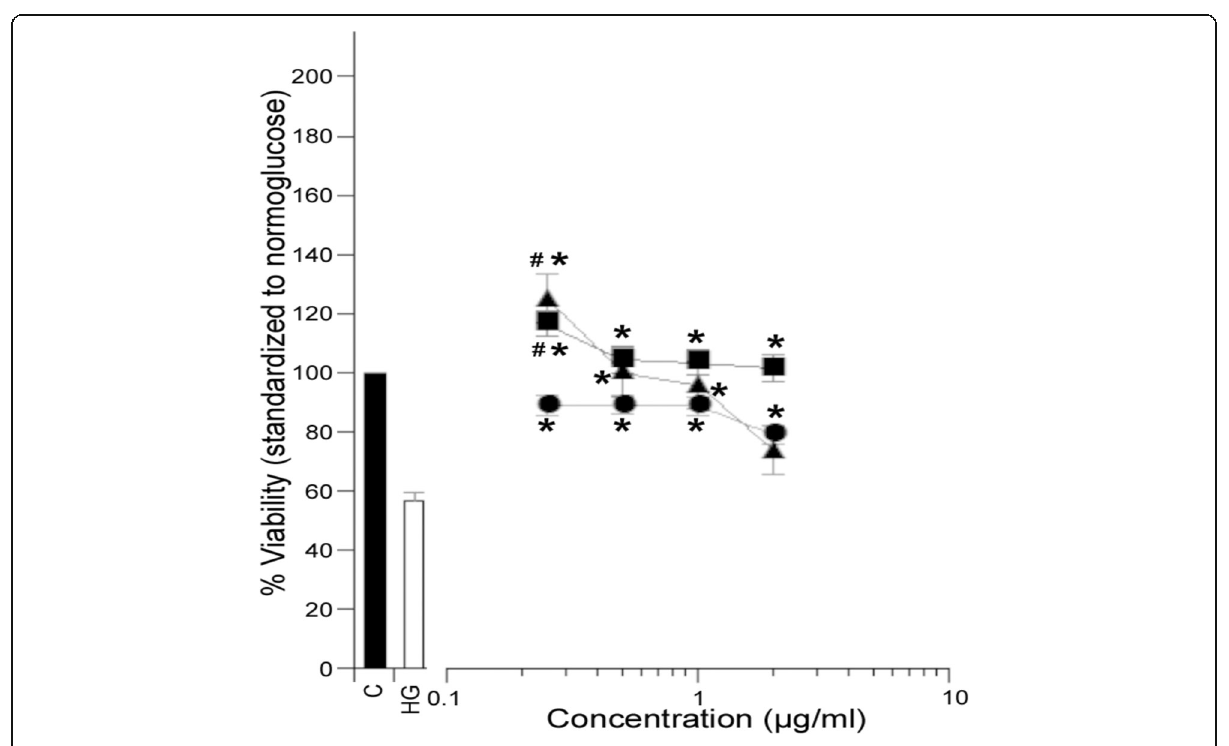
Fig. 2 Comparison of cytoprotective and mitogenic activities of P. mariana needle ( ● ), bark ( ■ ) and cone ( ▲ ) extracts in PC12-AC grown in hyperglycemic media. MANOVA analysis was used to average all extracts based on their organ type and concentration. Significant cytoprotection ( * ) or mitogenic activity (#) was afforded when Dunnett post hoc tests were p ≤ 0.05 as compared to the normoglucose (C) and high glucose (HG) controls. All organs showed significant protection at all concentrations except cone at 2 μ g/mL (needle n = 120, bark n = 60, cone n =